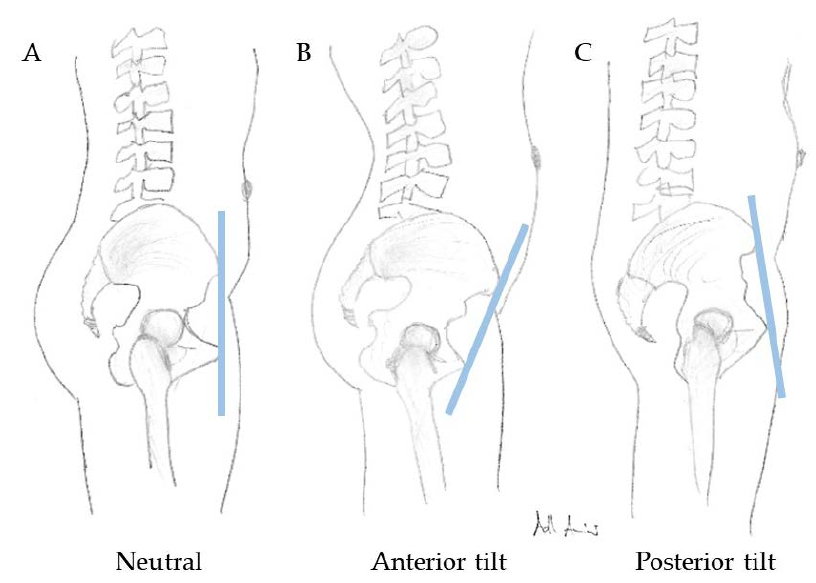
Figure 4. Neutral ( A ), anterior ( B ), and posterior ( C ) pelvic tilt